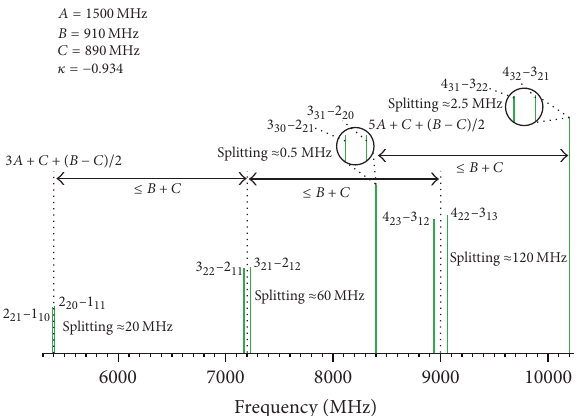
-branch transition patterns. Two and 3, the text should 𝑅𝑅 � 𝐵1 = 2 𝐾𝐾